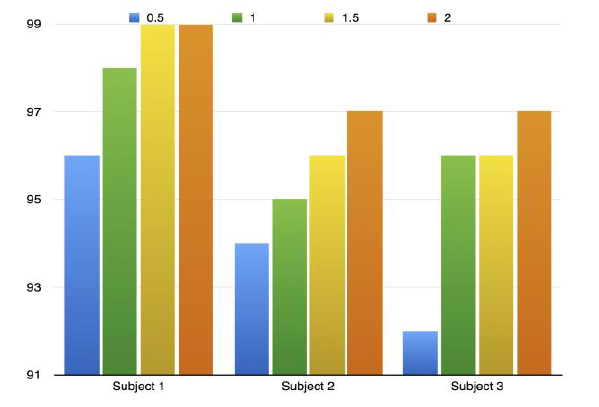
Figure 2: Impact of segment duration ( sd ) on accuracy (%).